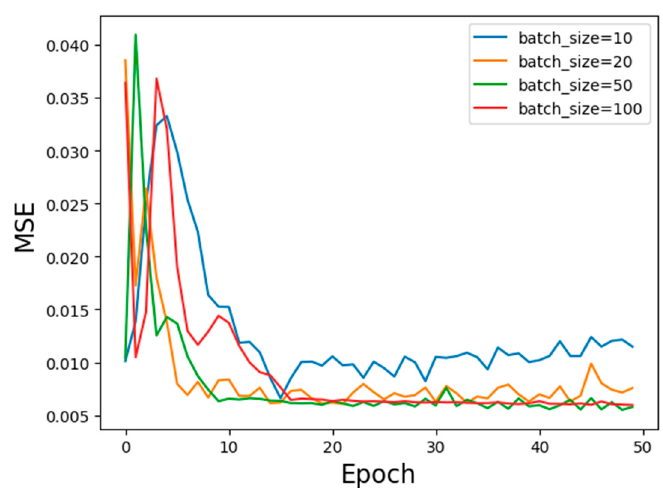
Figure 6. Comparison of batch size loss. MSE, mean square error.